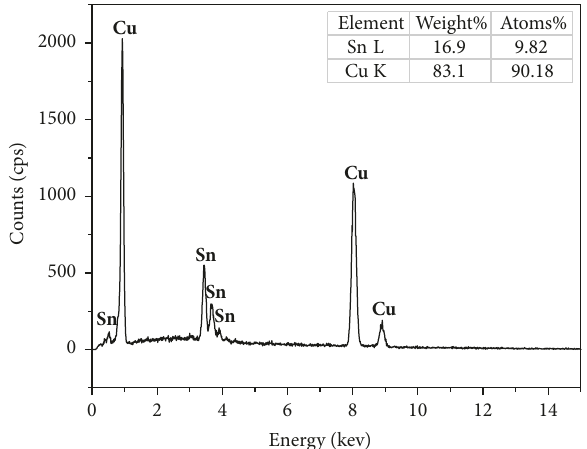
Figure 5: EDS spectra of the tin deposits electrodeposited from the [Bmim]HSO 4 ionic liquid containing 40mM SnO at -0.6 V and 353K.